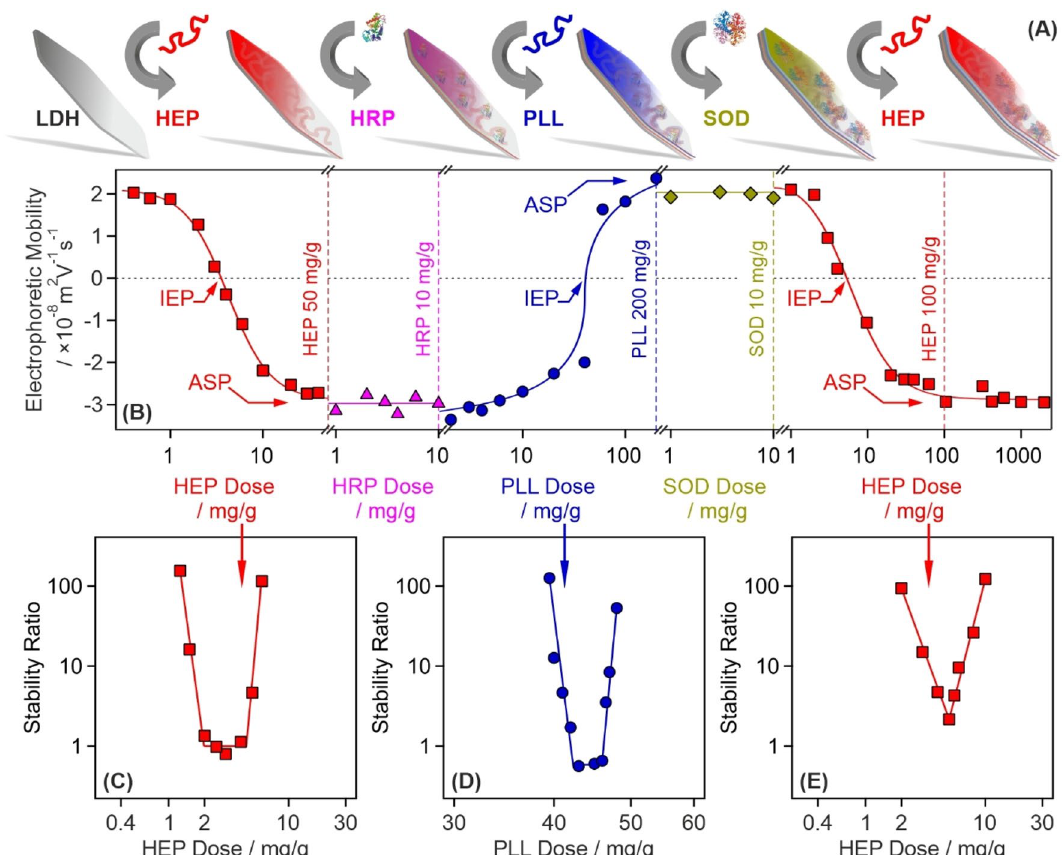
Figure 1. Illustration of the sequential adsorption process and tendencies in the charging and aggregation properties during the build-up of the polyelectrolyte-enzyme layers on the LDH particles. (A) Schematic representation of the preparation of the final CASCADE composite. (B) Changes in electrophoretic mobilities during the sequential adsorption procedure illustrated in (A) . The dashed vertical lines show the doses used in the synthesis of CASCADE. (C) Stability ratio of LDH particles as a function of the HEP dose. (D) Stability ratio of LDH–HEP–HRP particles as a function of the PLL dose. (E) Stability ratio of LDH–HEP–HRP–PLL–SOD particles as a function of the HEP dose. Note that the mg/g unit refers to mg of polyelectrolyte or enzyme per one gram of LDH particles. The solid lines are just to guide the eyes. IEP and ASP are abbreviations of doses corresponding to the isoelectric point and to the onset of the adsorption saturation plateau, respectively. The electrophoretic mobilities were determined with ± 10 –9 m 2 V −1 s −1 precision, while the average error of the stability ratios is